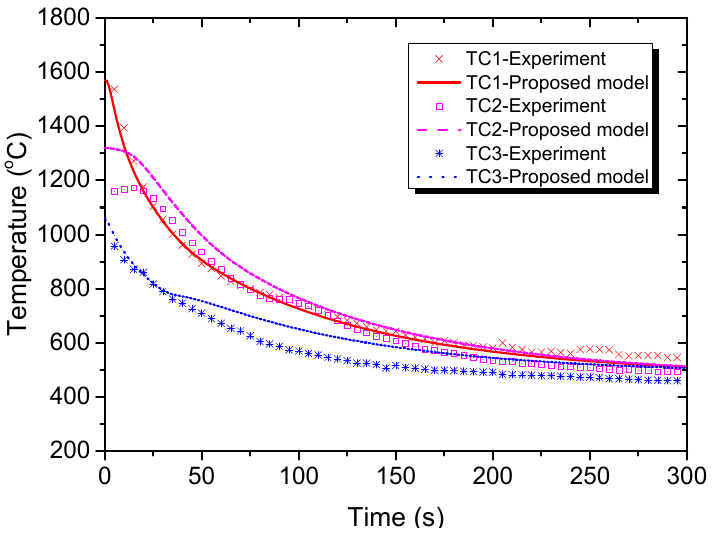
Figure 6. Temperature variation at three locations in the EBBM sample. TC = thermocouple.